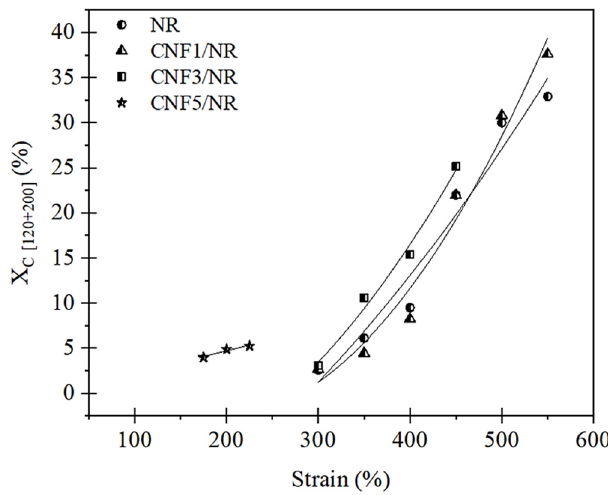
Figure 7. Degree of crystallinity ( X c ) as a function of the applied strain for the NR and the CNF/NR nanocomposites.